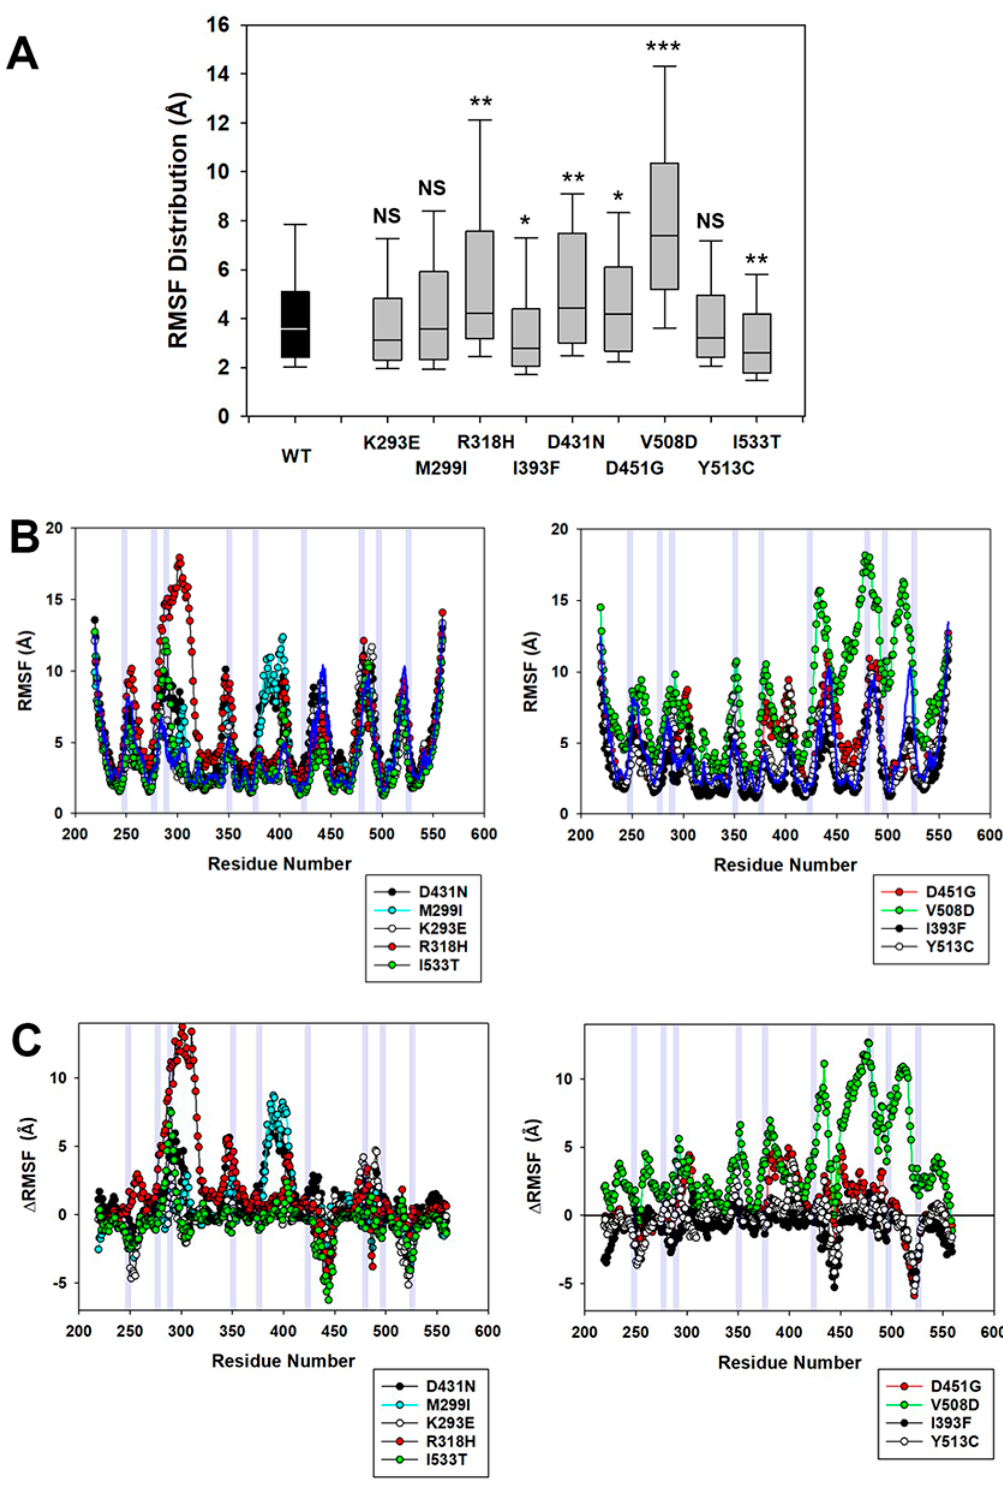
Figure 2. Molecular Dynamics Analysis of OCRL1 variants. ( A ). Box plots represent the distribu- tion of individual residue fl uctuations measured as RMSF throughout the phosphatase domain of OCRL1 WT and the indicated OCRL1 VAR . All distributions were statistically compared to that corre- sponding to OCRL1 WT , using the Kolmogorov–Smirnov test with p < 0.05; applying Bonferroni’s correction for nine comparisons; α B ≤ 0.005 (*), α B ≤ 0.001 (**) and α B ≤ 0.0001 (***) for individual comparison. NS: Not signi fi cant. ( B – C ). Panels show RMSF ( B ) and ∆ RMSF ( C ) values for the indi- cated OCRL1 VAR at individual residue positions. For clarity reasons, values for OCRL1 VAR were plot- ted in two graphs shown (left and right) with ≤ 5 variants per graph bearing substitutions as